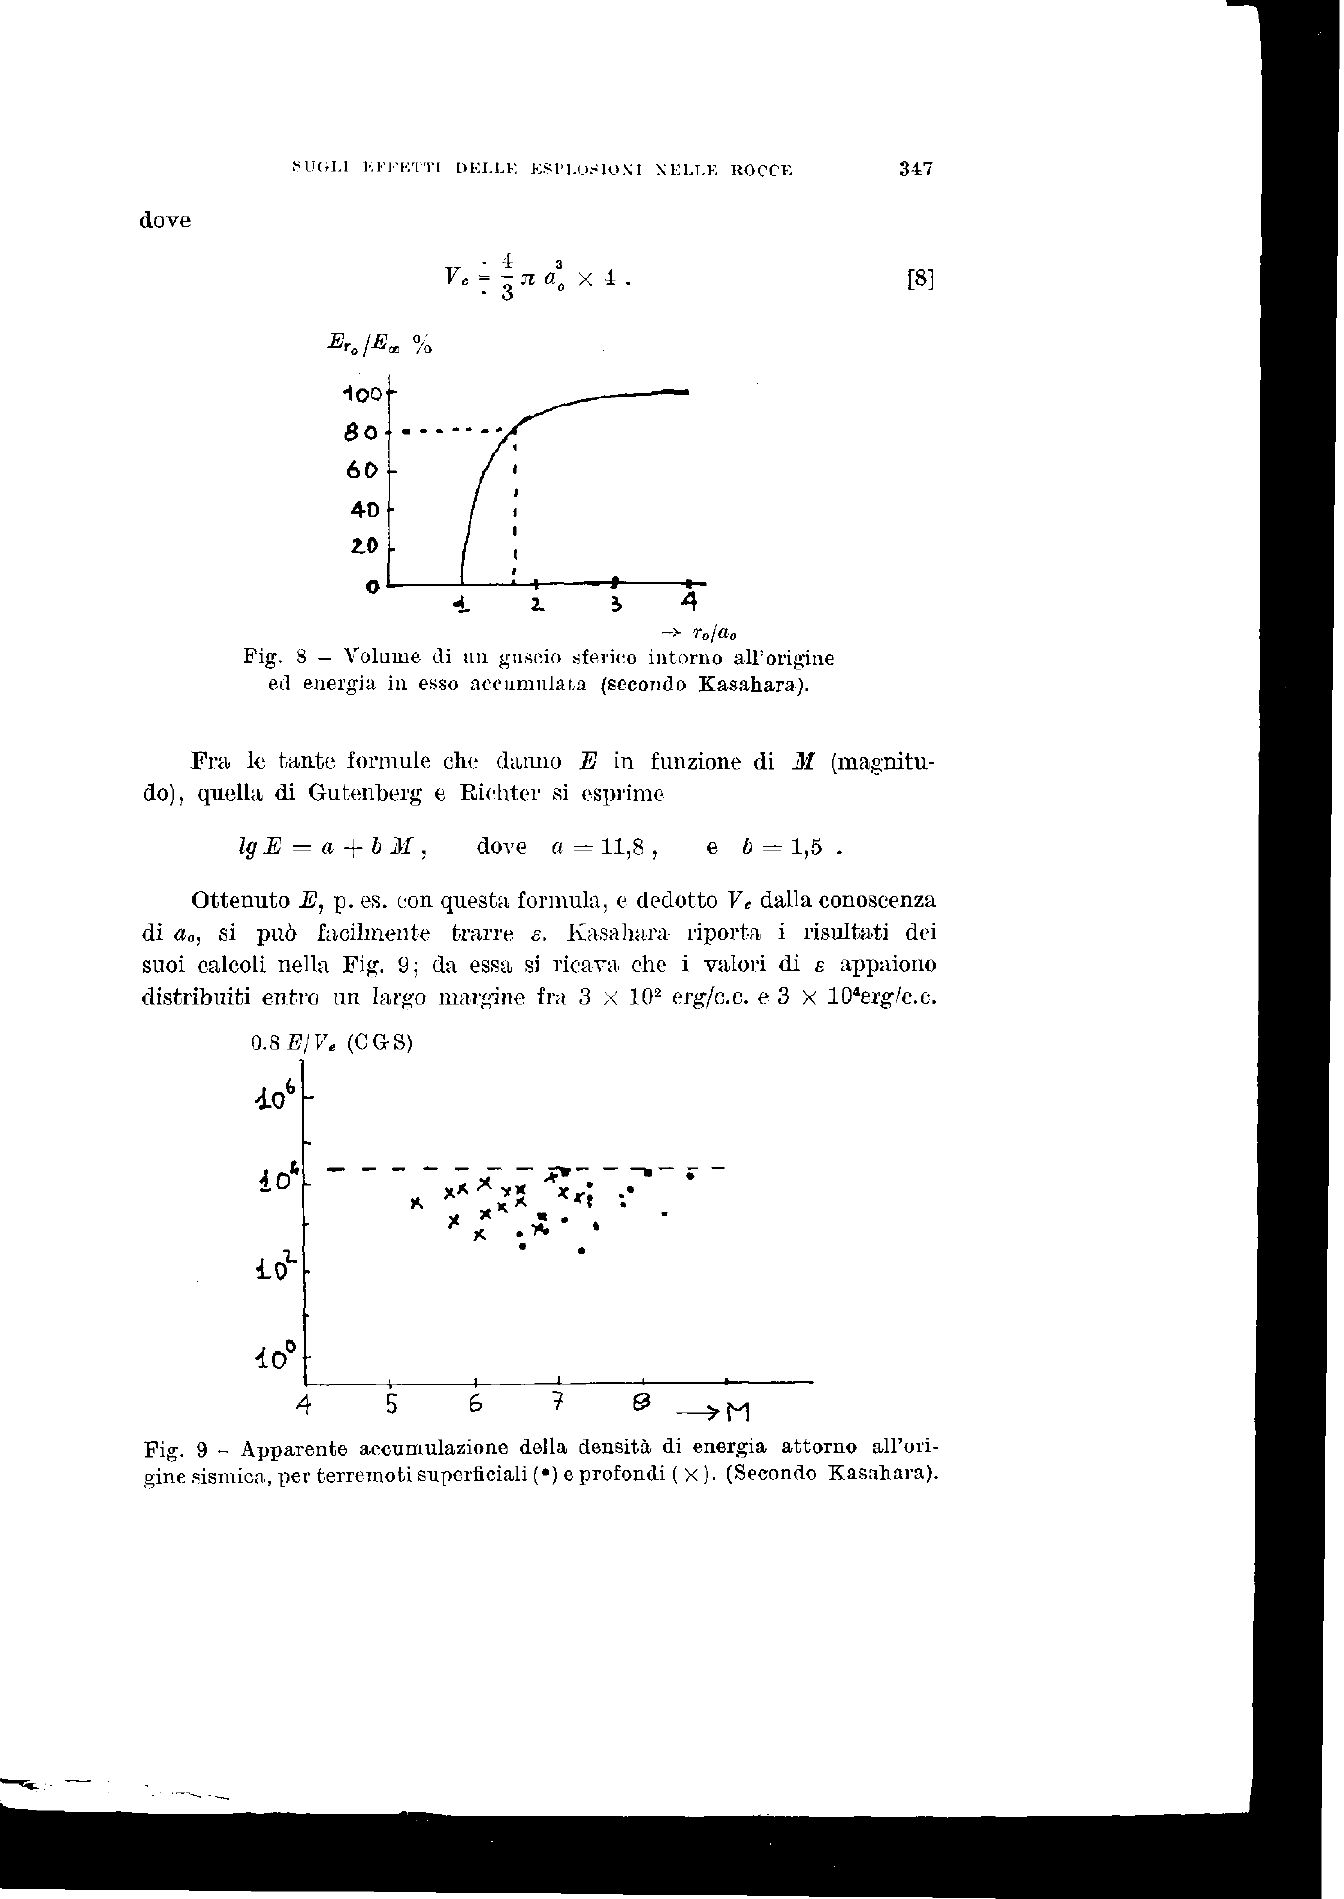
Fig. 9 - Apparente accumulazione della densità di energia attorno all'ori- gine sismica, per terremoti superficiali (•) e profondi ( x ). (Secondo